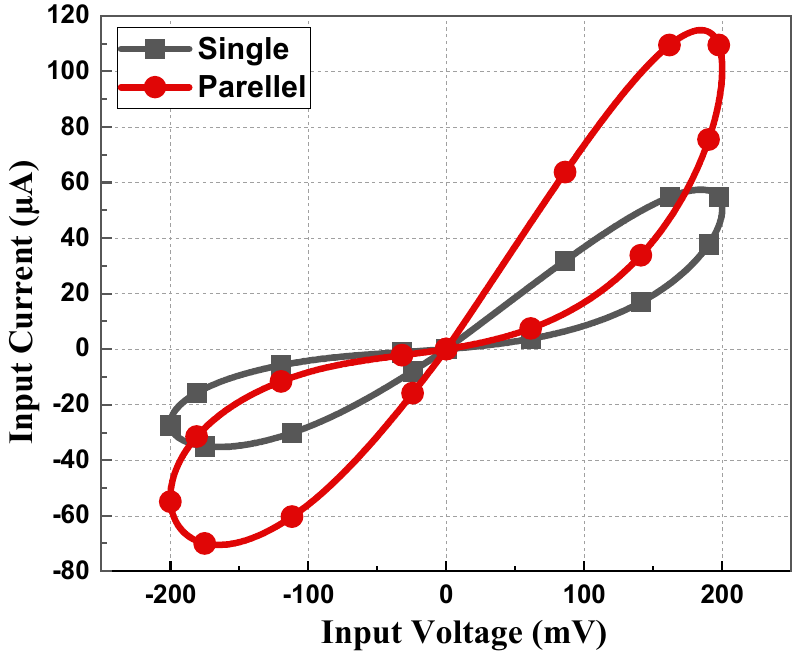
( b ) Figure 13. ( a ) Layout of proposed memristor design. ( b ) Pre-layout and post-layout PHL. Various connections of the proposed design are tested in Figure 14. Parallel connec- tions have less memristance value and conduct more current than single memristors. From Figure 14, it is clearly observable that parallel connections have a bigger loop and a large current value compared to single memristor PHLs. Figure 15 demonstrates the PHL